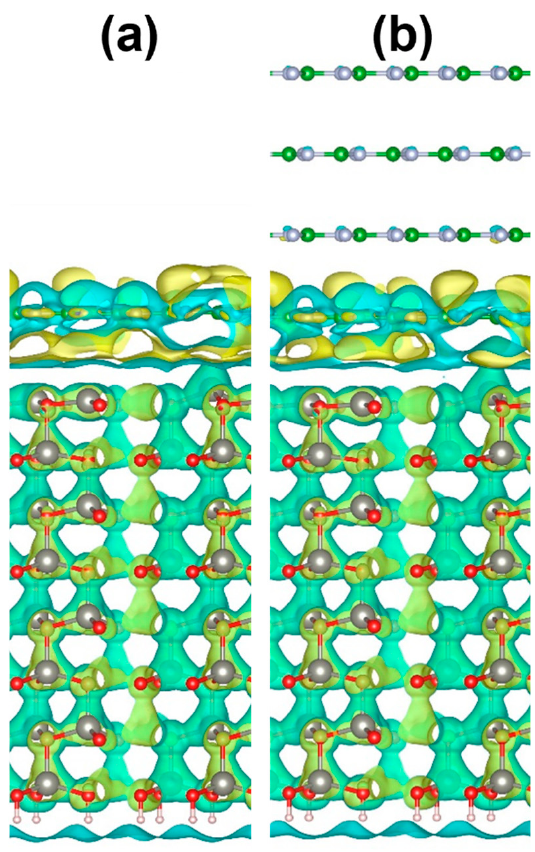
Figure 8. Charge difference distribution between h-BN and wZnO for ( a ) 1L-hBN/wZnO and ( b ) 4L-hBN/wZnO heterostructures. Yellow and blue clouds show the accumulation and loss of electrons. The isosurface level is 5 × 10 − 5 e/Å 3 .